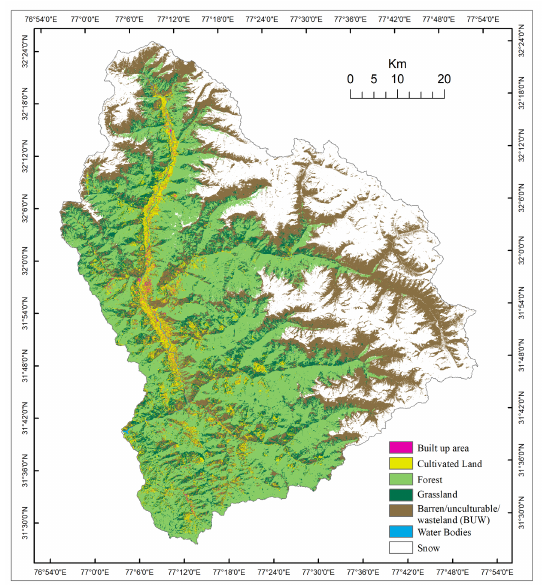
Figure 3. Land use/land cover conditions of the upper Beas basin in the year 1991